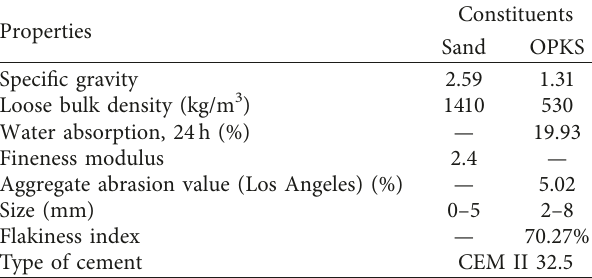
Table 1: Physical properties of constituents of OPKS concrete grade-20